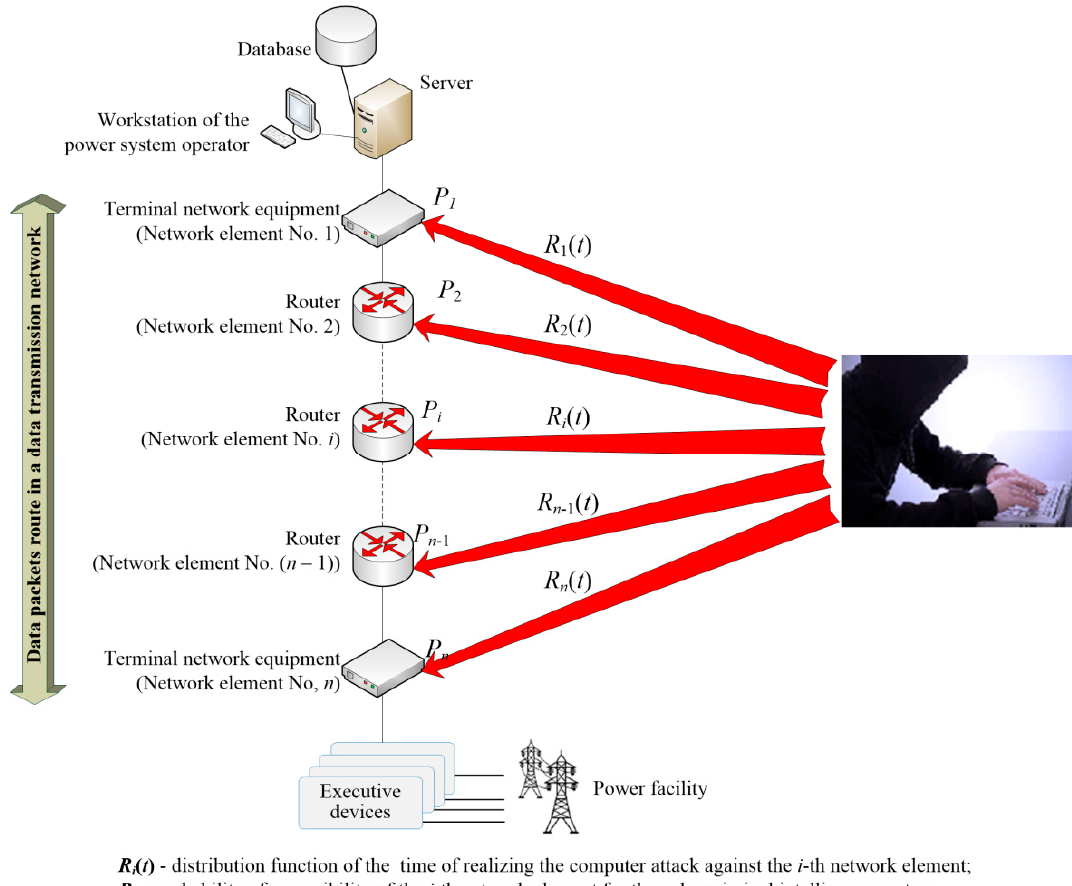
Figure 2. The route plan of the data packets’ transmission in a network, functioning in the context of cyberattacks.